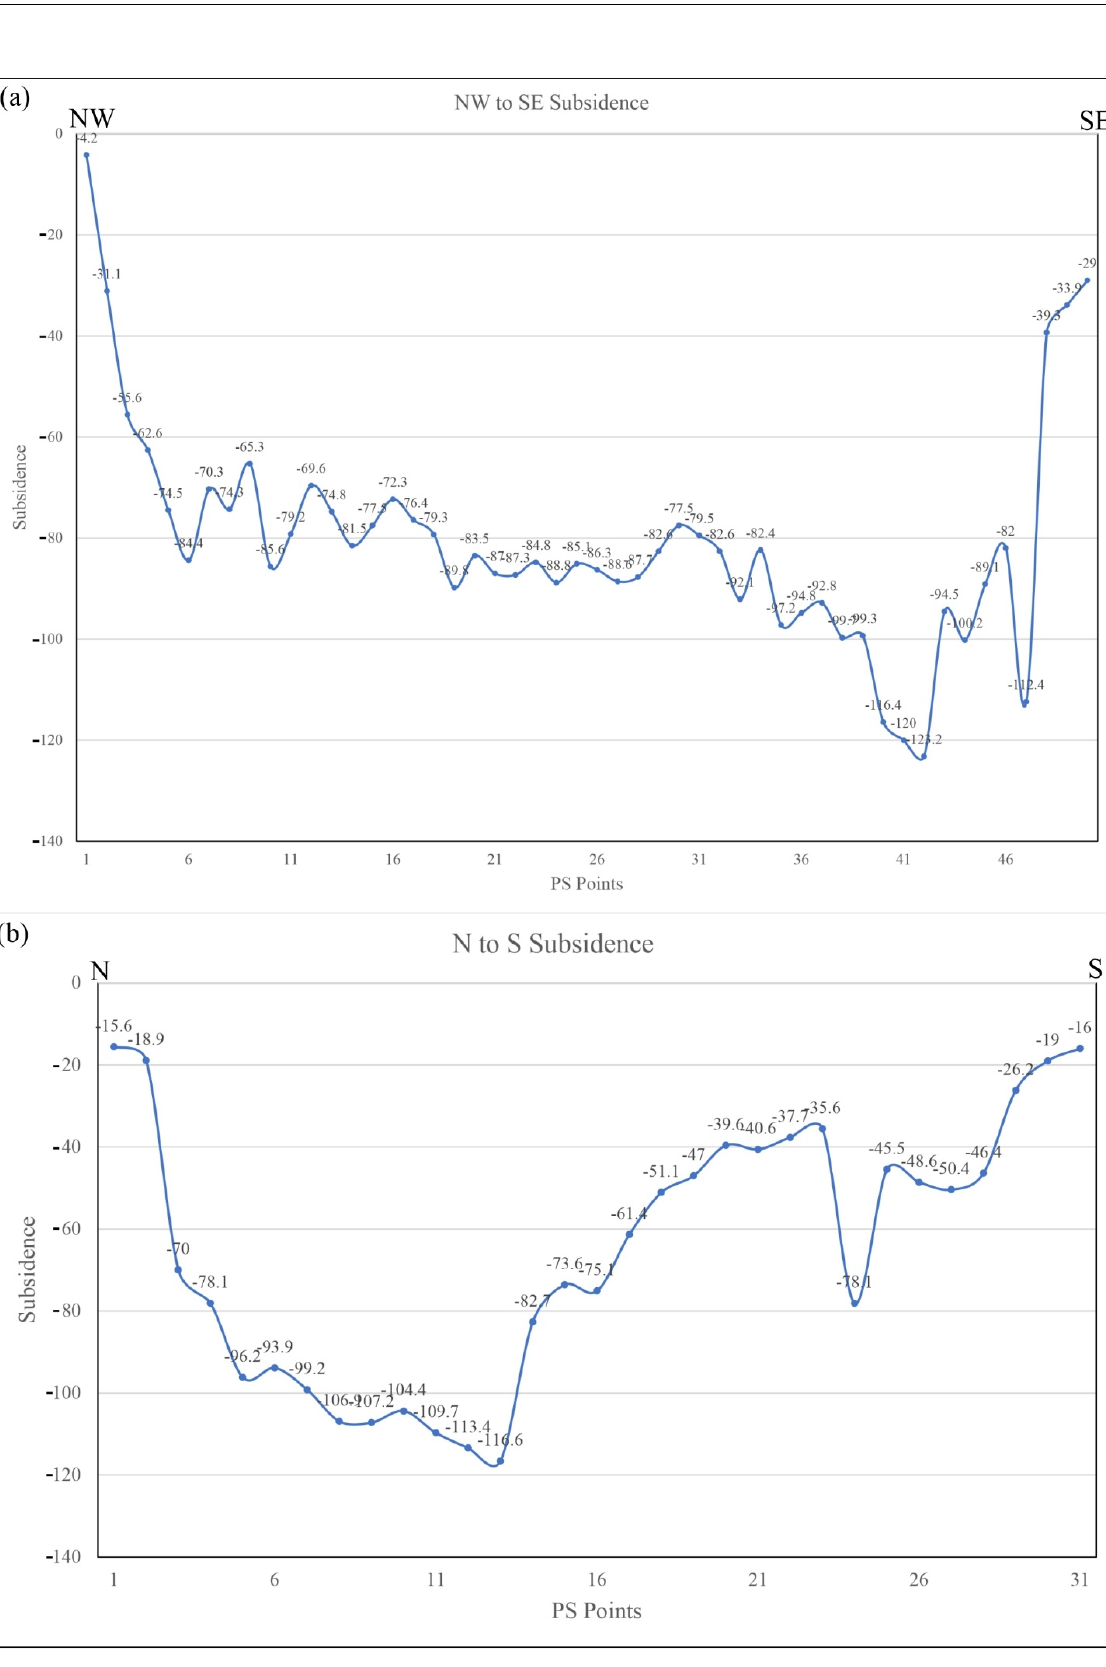
Figure 14. ( a ) North-West to South-East subsidence trend graph (January 2019–June 2021; ( b ) North to South subsidence trend graph (January 2019–June 2021).